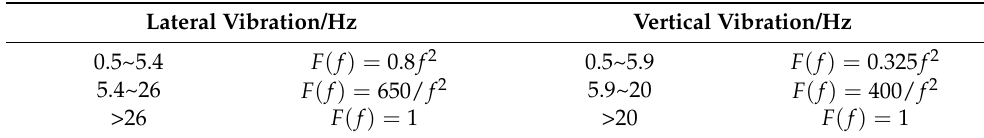
Table 1. The frequency weighting formula of the Sperling